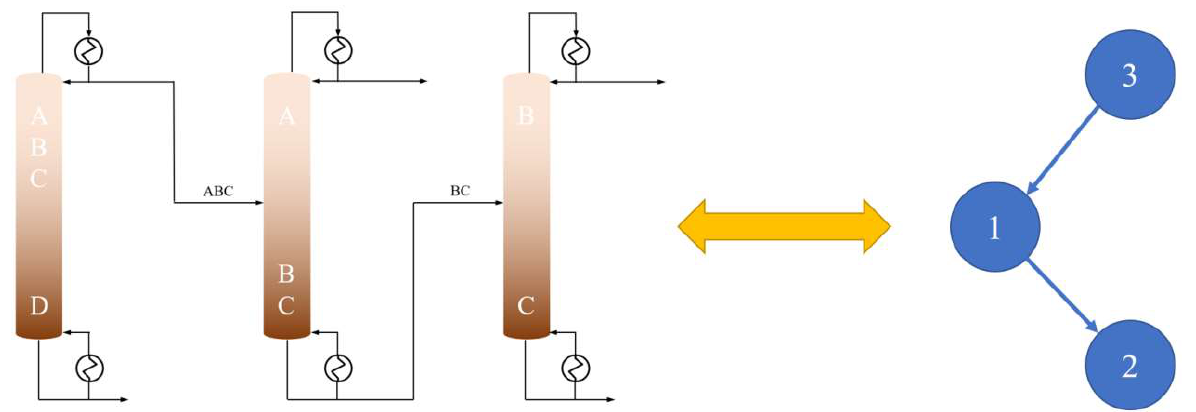
Figure 6. Diagram of separation sequence and binary tree. A, B, C, D are the four components of the mixture and 1, 2, 3 represent the numbers of separation positions.